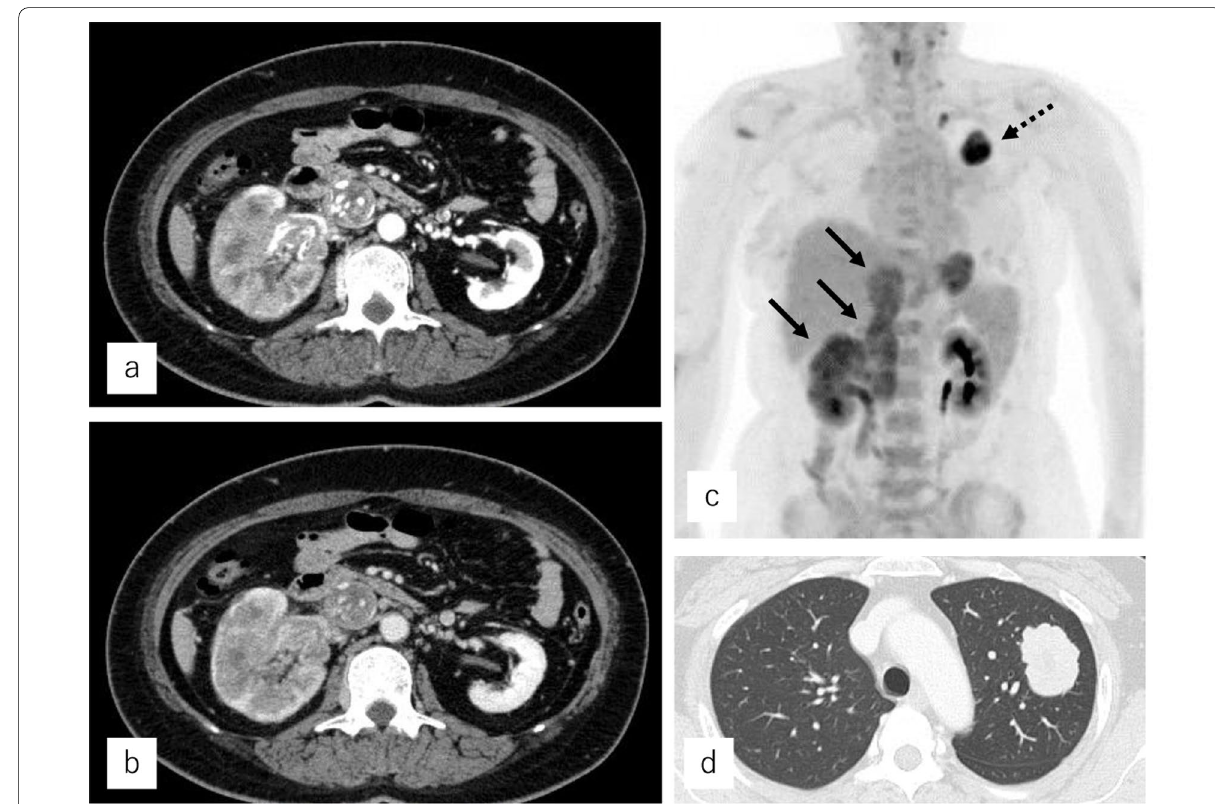
Fig. 1 Contrast-enhanced CT. A right renal tumor is occupying the entire right kidney and protruding outside the cortex. There is a tumor thrombus visible in the inferior vena cava on early phase ( a ) and late-phase ( b ) imaging. Positron emission tomography–CT shows kidney metastasis with a tumor thrombus in the inferior vena cava (arrows) and lung metastases (dashed arrow) ( c ). Plain CT shows a tumor in the left lung ( d